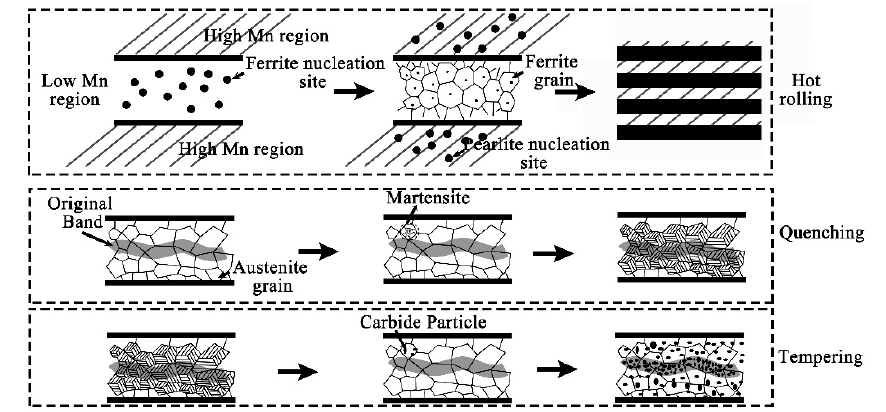
Figure 13. Illustration for the evolution of banded structures from hot rolling to QT treatment.